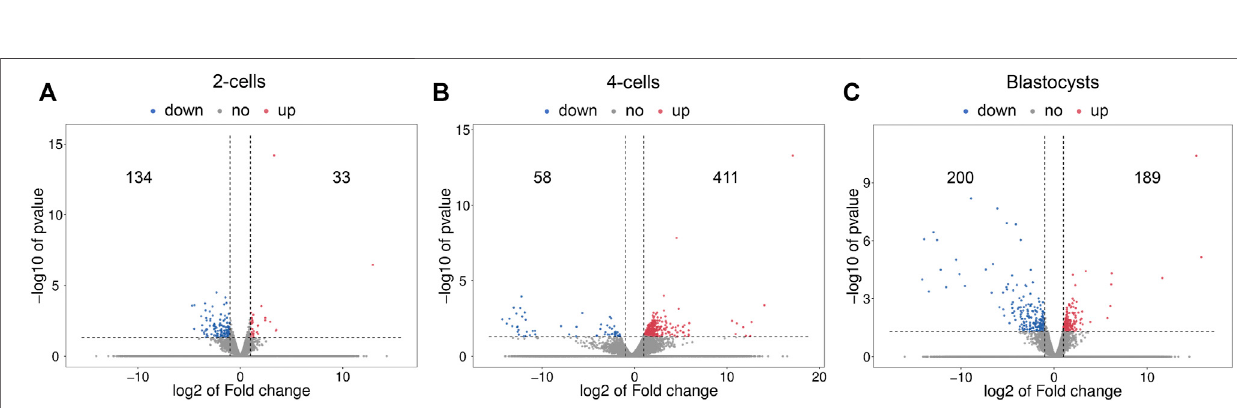
Table S9 ). 15 pairs of lncRNA-mRNA were identi fi ed in 2-cells from vitri fi ed and fresh zygotes, and the target genes contained